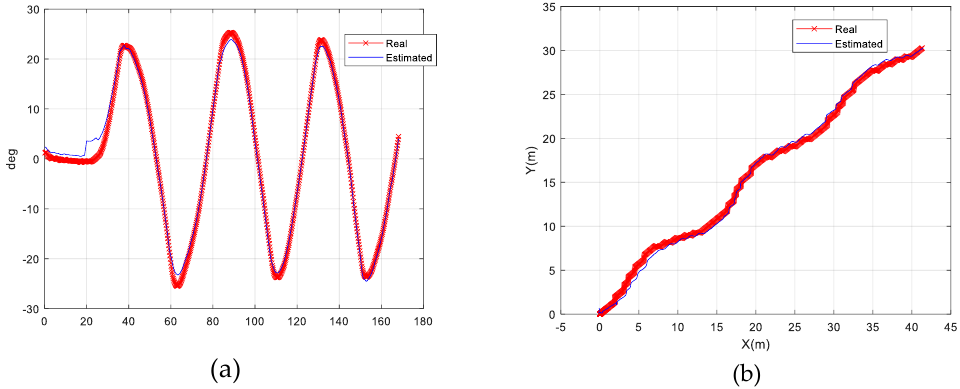
Figure 7. Trial #4 — Zig-Zag 20 – 20. ( a ) Heading angle estimation; ( b ) trajectory prediction. Figure 7. Trial #4—Zig-Zag 20–20. ( a ) Heading angle estimation; ( b ) trajectory prediction. Table 4. Zigzags error measures ( r ).